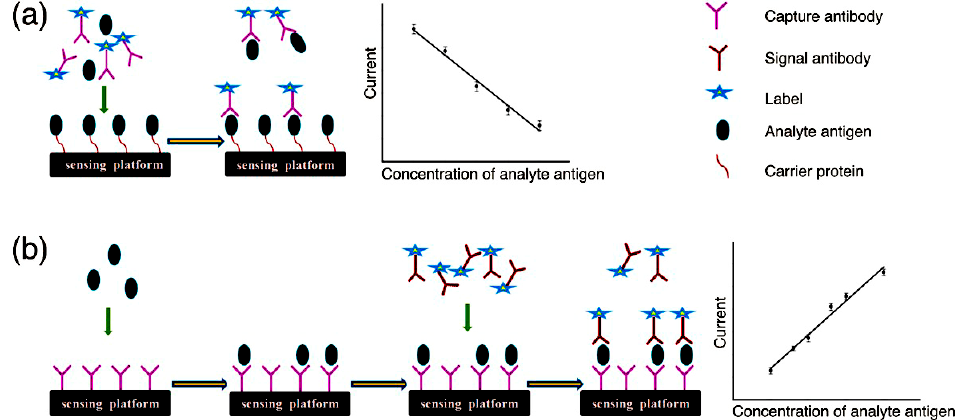
Figure 1. A schematic representation of ( a ) competitive immunoassays and ( b ) noncompetitive immunoassays [31]. Copyright (2016) Wiley.